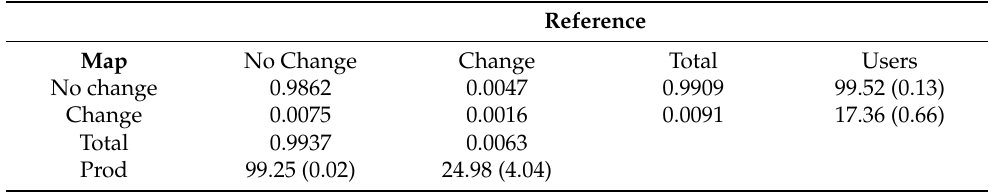
Table 8. Error matrix for the binary change and no-change classification for 2005–2010. The values in parentheses are standard deviations. OA = 98.78 ± 0.14%.